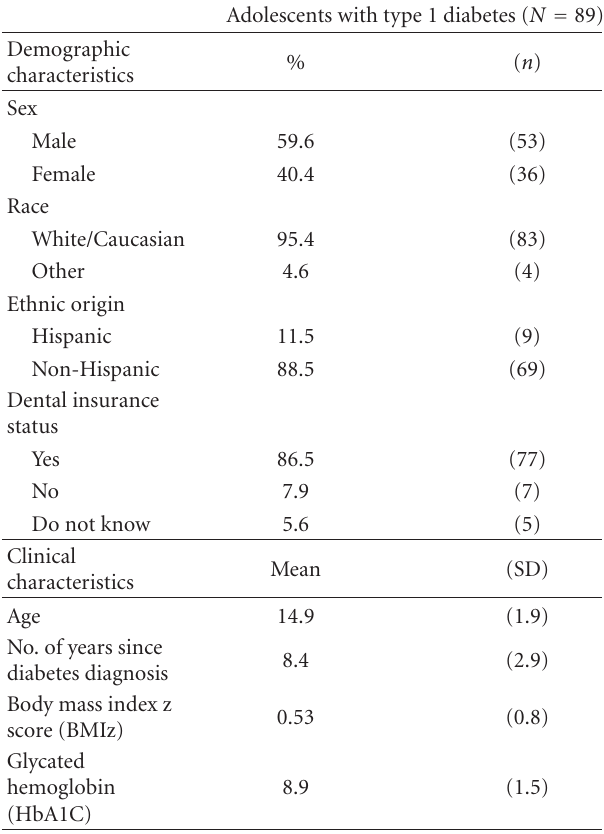
Table 1: Select characteristics of participants.